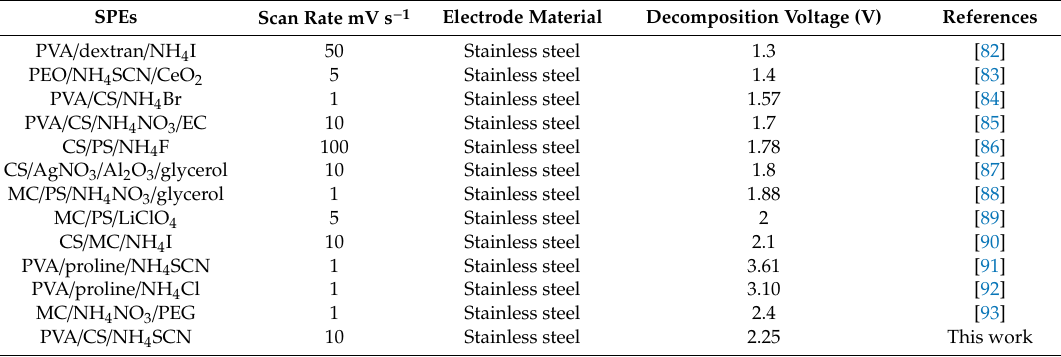
Figure 8. Linear sweep voltammetry plot for the PCSH4 sample at room temperature. Table 3. The comparison of decomposition voltage of various SPEs.